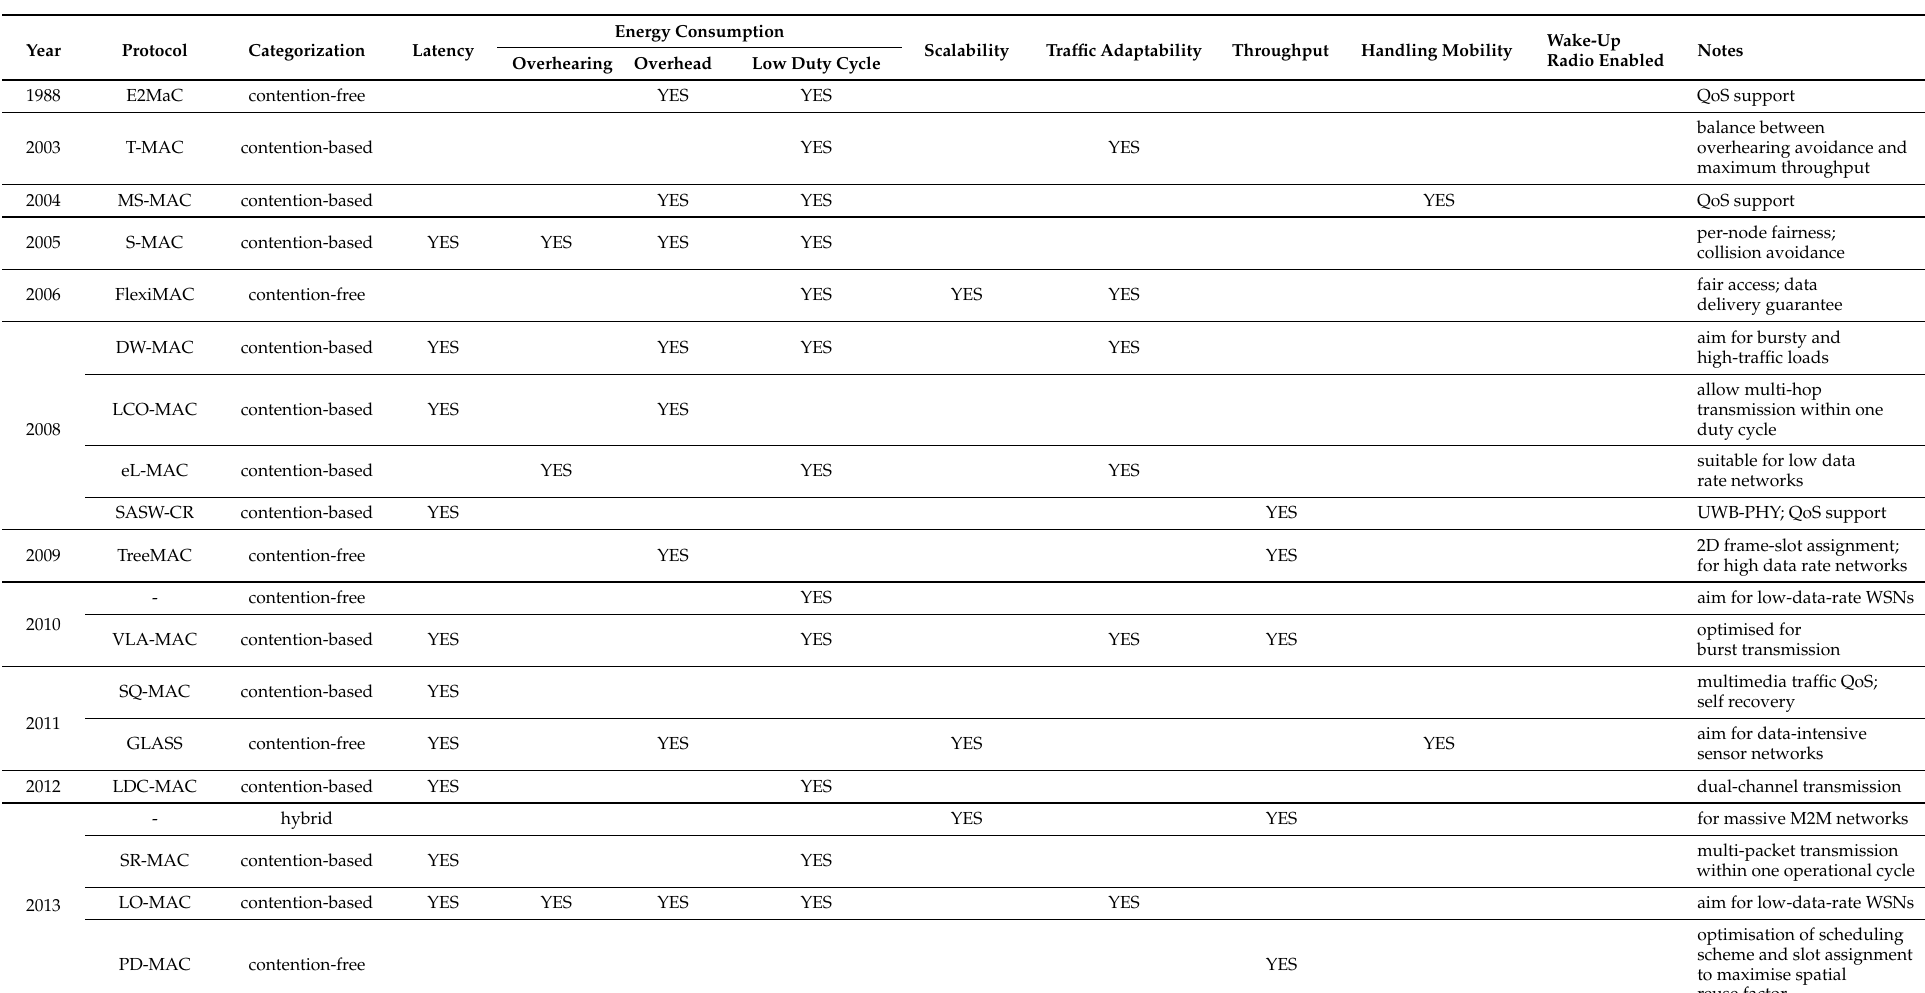
Table 6. Summary of Capable Features Based on Existing MAC